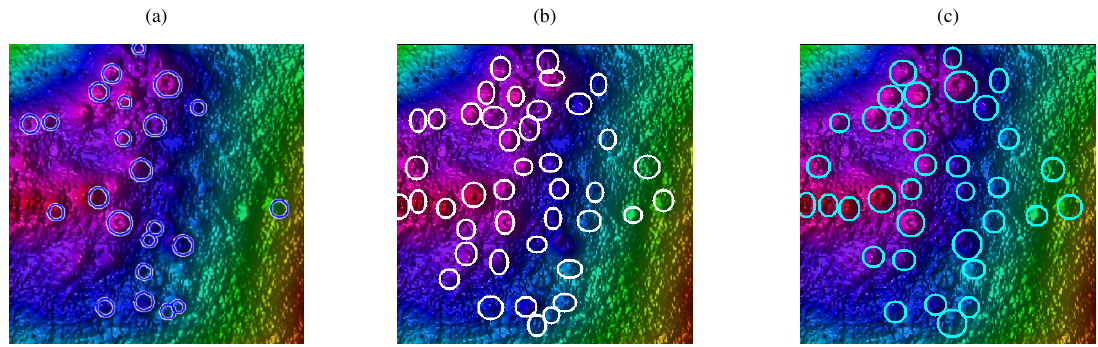
Figure 3. Hough transform, Marked Point Process Model and reference data (from left to right